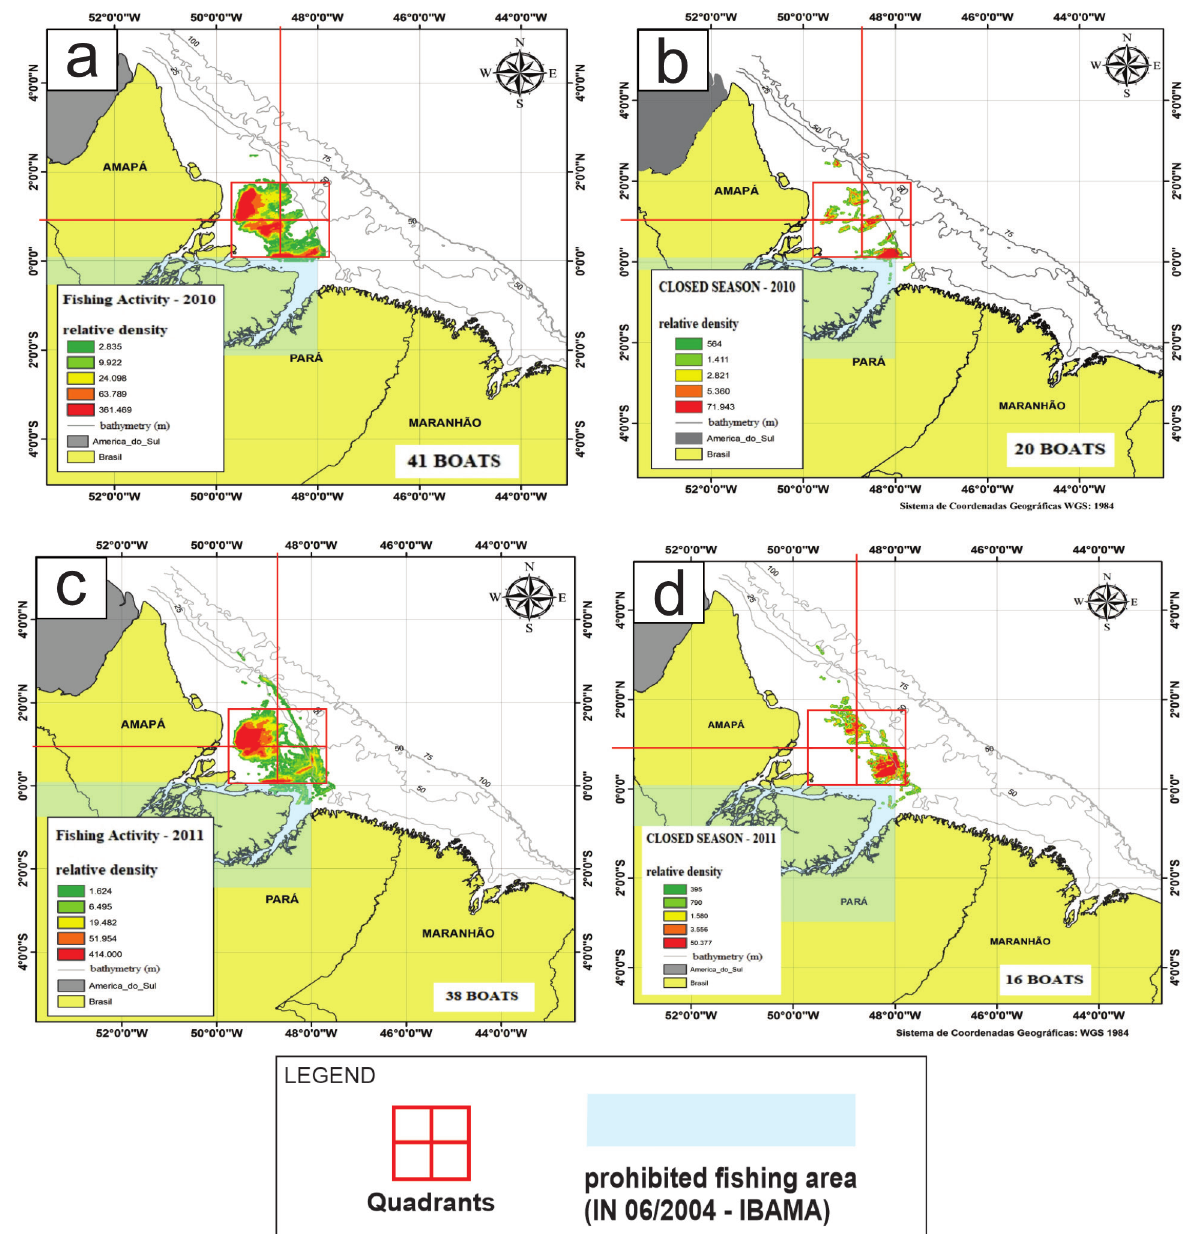
Figure 6. Dynamics of the industrial fleet capturing B. vaillantii and relative density of fishing activity from 2010 (Figures. a and b) to 2011 (Figures c and d); in the normal period and in the closed period of the species. The segment outlined in red shows the total area within which the piramutaba trawling fleet